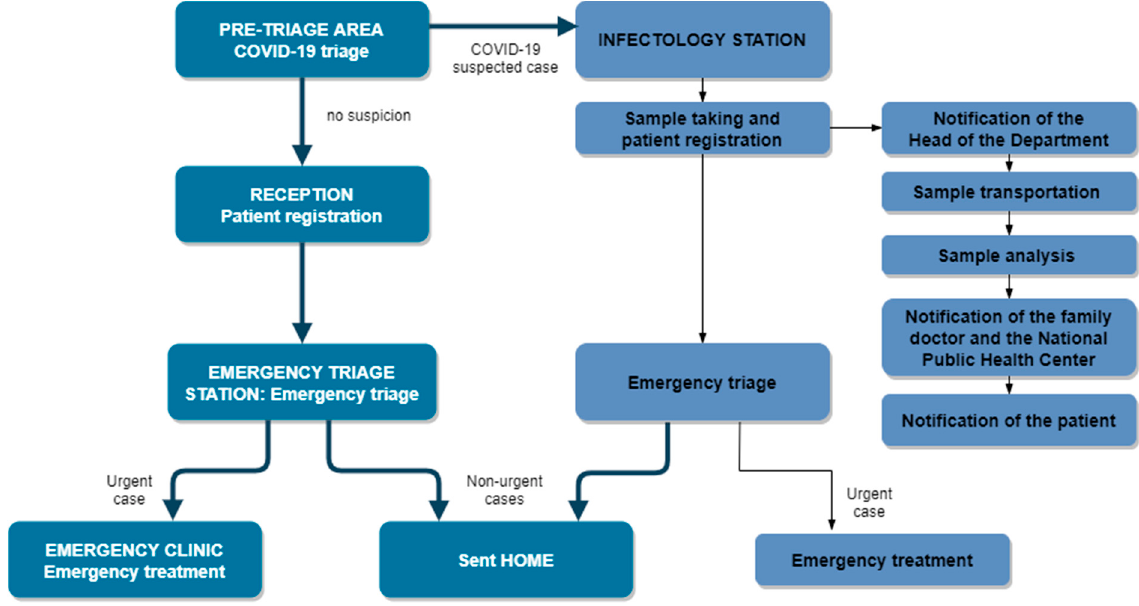
Figure 1. Patient pathways in the Department of Community Dentistry of Semmelweis University.